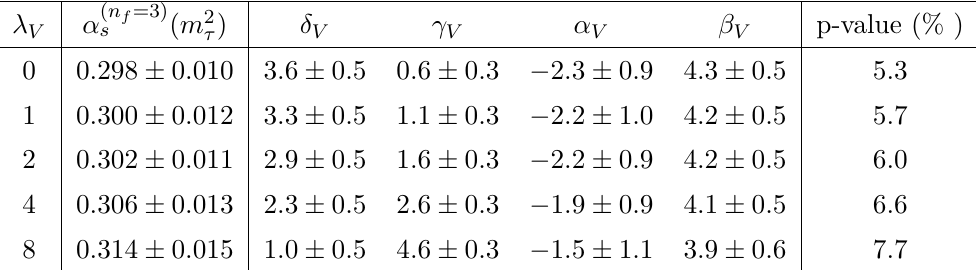
Table 14 . Fitted values of α ( n f =3) s ( m 2 with ˆ s = 1 . 55 GeV 2 , for different values of the power λ 0